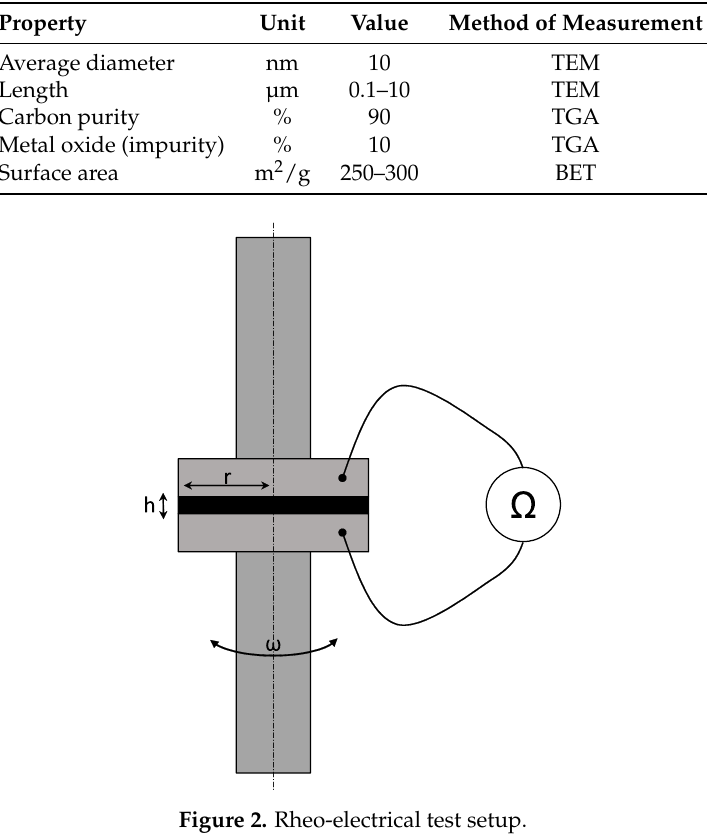
Table 2. Properties of Nanocyl NC7000 multi-walled carbon nanotubes.